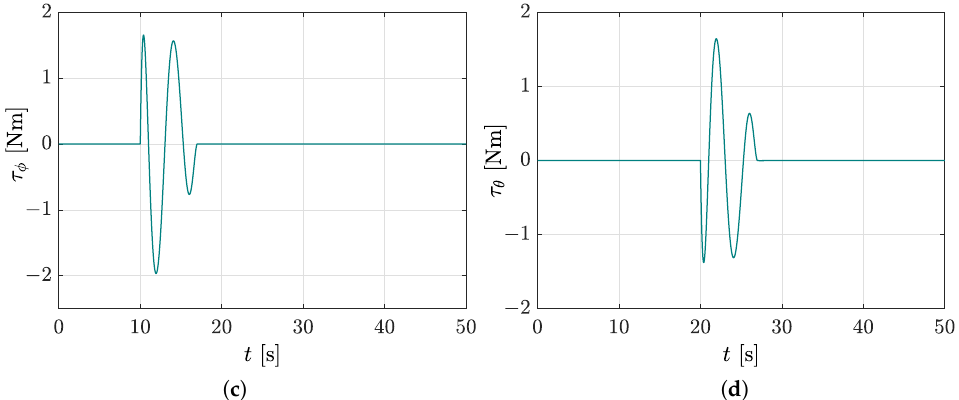
Figure 5. Control inputs for the unperturbed motion. ( a ) Main force input u . ( b ) Computed control